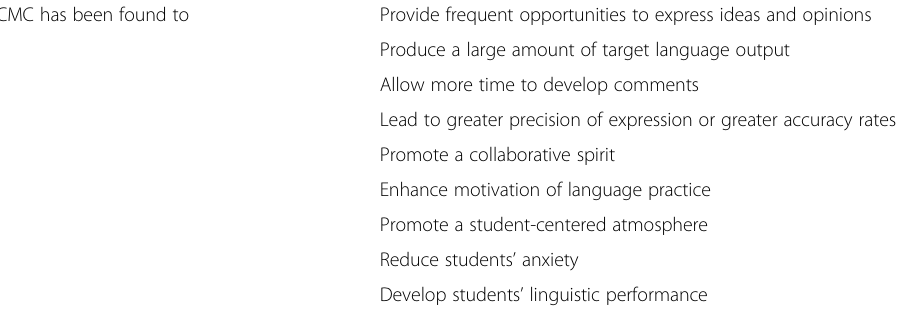
Table 1 Advantages of CMC in promoting communication, interaction and socialization (Gleason & Suvorov, 2011; Lee, 2011) CMC has been found